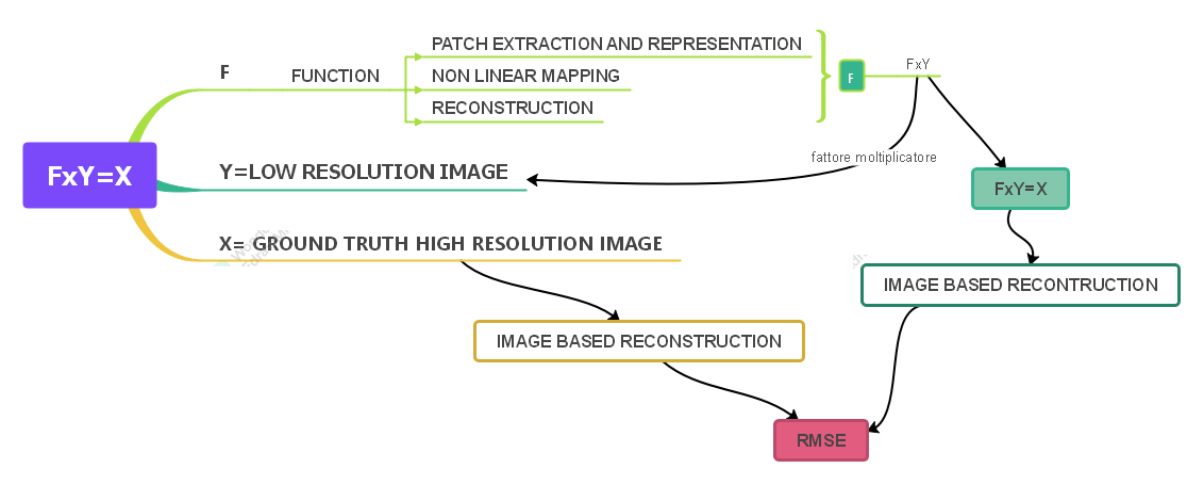
Figure 1. Flow Chart Methodology.